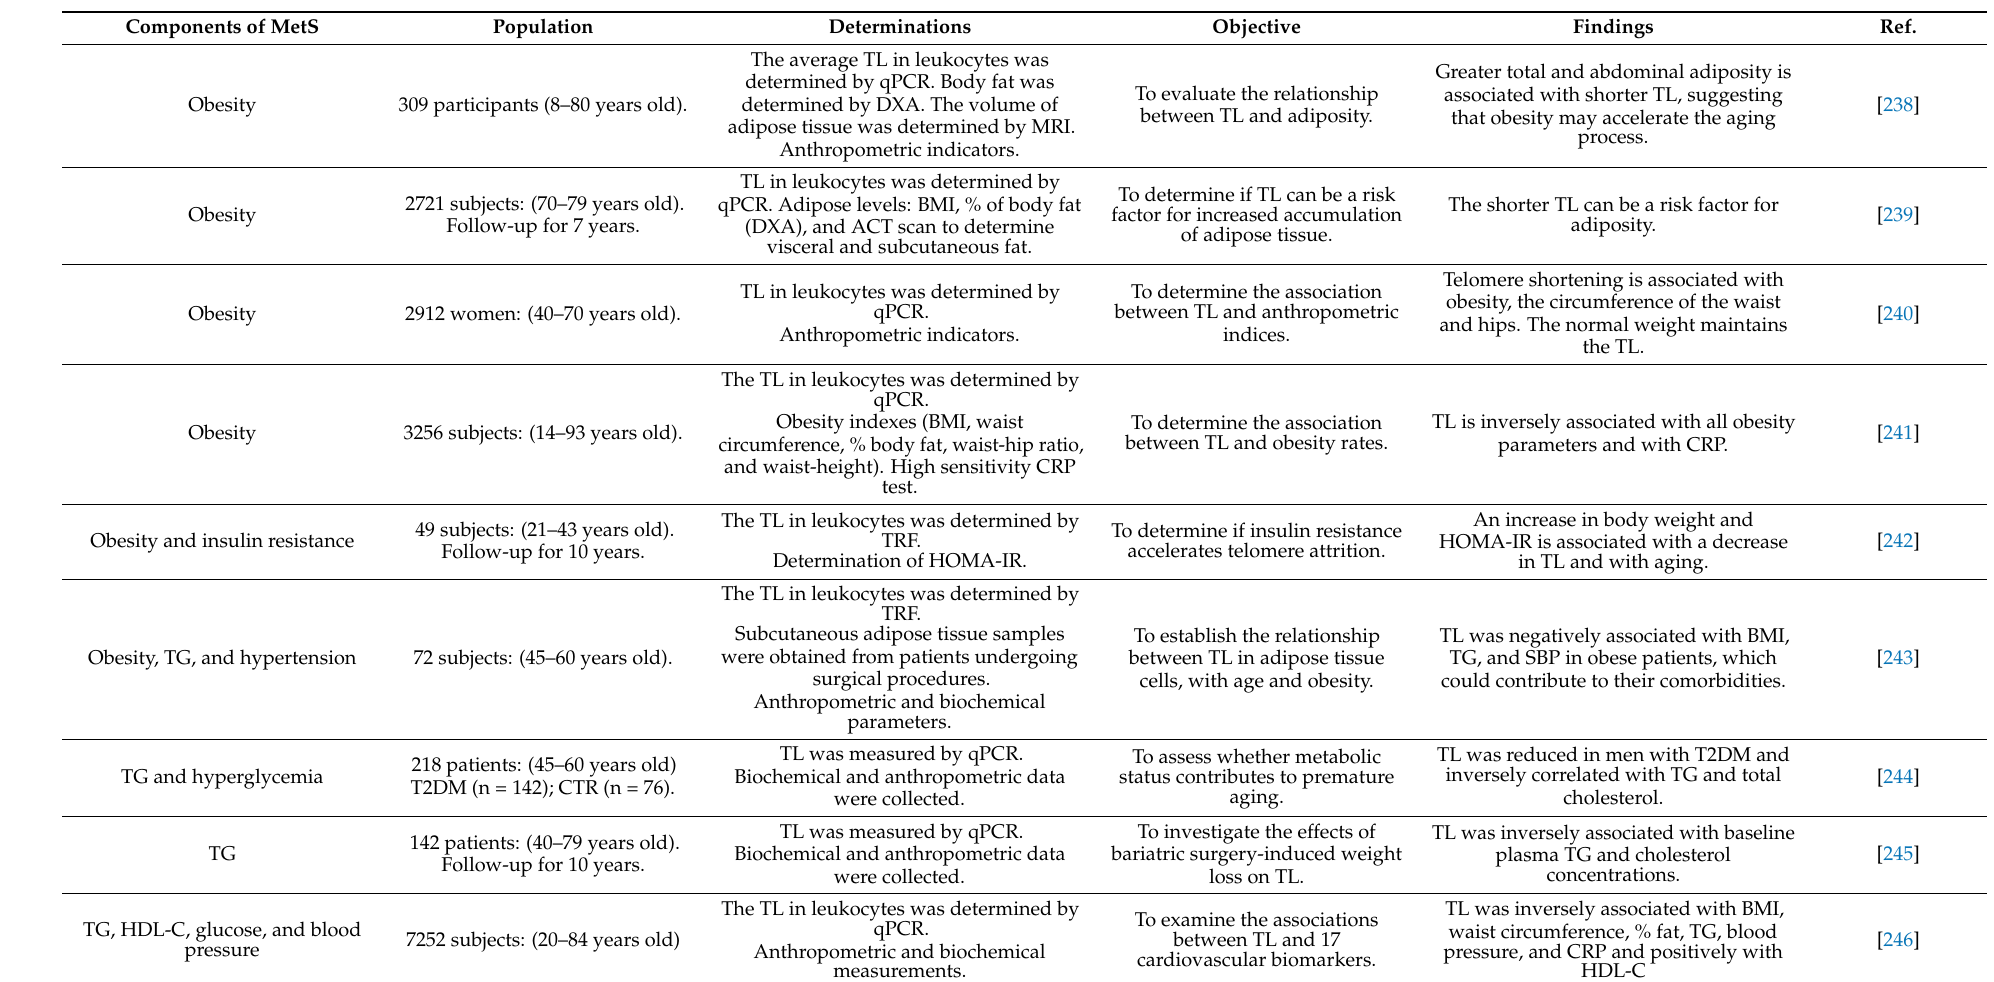
Table 3. Components of MetS and its association with telomeric